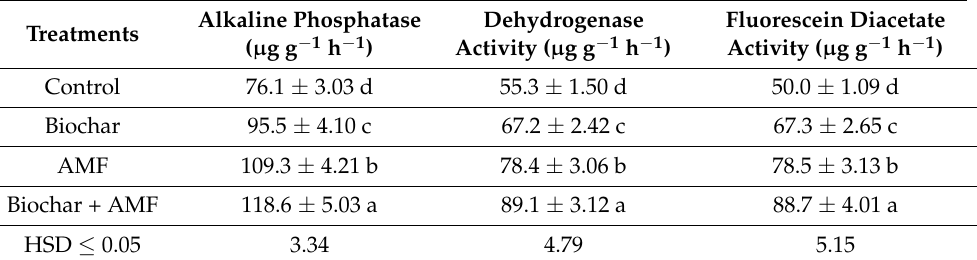
Table 4. Impact of biochar and AMF on soil enzymes